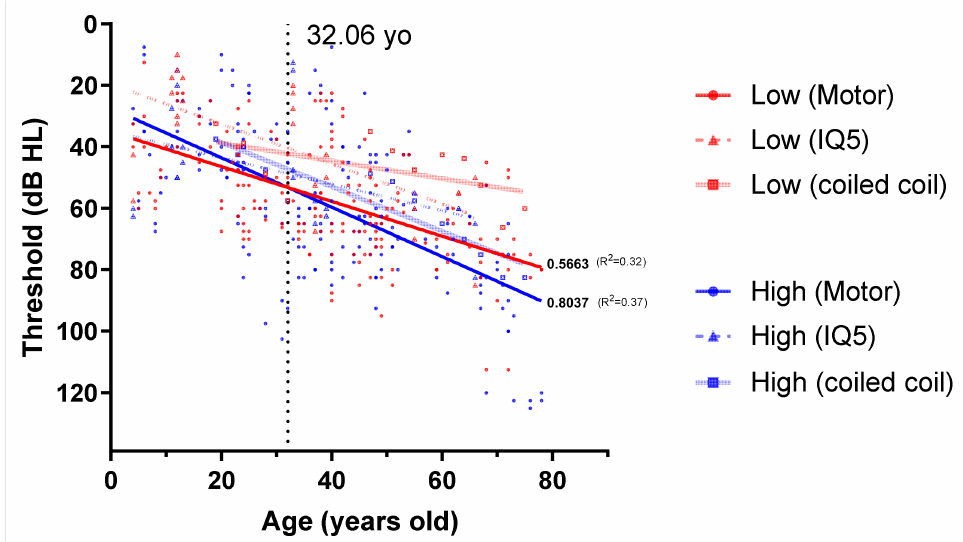
Figure 3. Changes in low and high frequency hearing thresholds by age for MYO7A variants. The hearing thresholds from literature with MYO7A variants are represented with red (low frequency: 250~500 Hz) and blue (high frequency: 2000~4000 Hz). Lines correspond to linear regression of best fit. Pure tone audiometry (PTA) results of 70 individuals with motor domain, 12 with IQ domain, and 5 with coiled-coil domain variants were denoted as circles with line, circles with dashed line and rectangles with transparent line, respectively. Unlike in other regions of MYO7A, variants in the motor domain showed low-frequency dominant hearing loss, particularly until the fourth decade (32.06 years old). PTA results of motor domain variants showed more rapid progression in high frequency deterioration like that of the other variants in functional domains, such as IQ or SAH domain, from the fourth decade (R 2 :